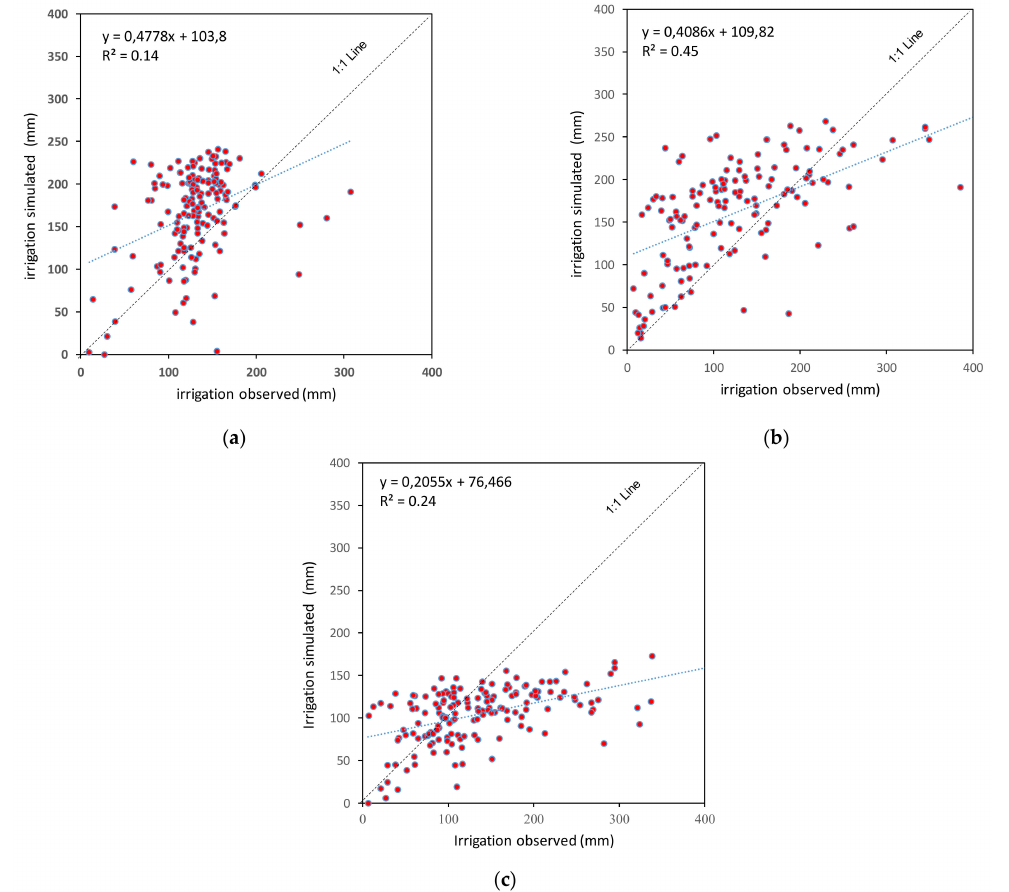
Figure 7. Comparison between observed irrigation supply and modeled irrigation water require- ments at field level in the three seasons ( a ) 2002, ( b ) 2005–2006 and ( c )